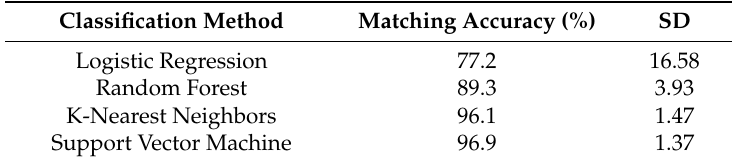
Table 2. Accuracy of the developed digital shade-matching device using the SVM algorithm and other classification algorithms by leave-pair-out cross validation ( p =